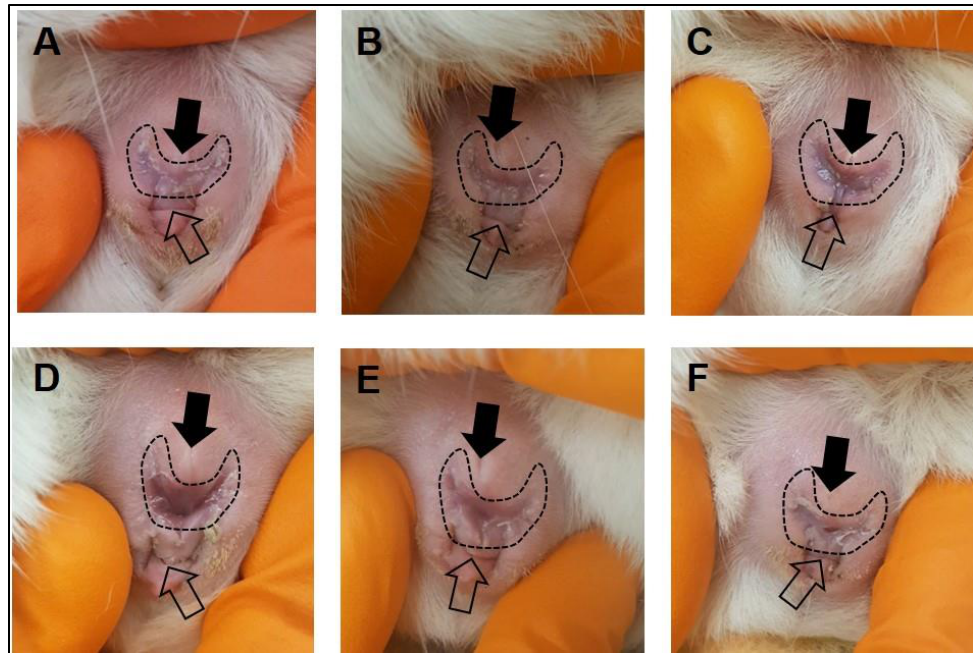
Figure 1. Monitoring of the guinea pig vaginal membrane. During the latent period of the estrus cycle, the guinea pig vaginal membrane (dashed outline) is visibly closed ( A , B ). Four to five days prior to ovulation, changes to the color of the vaginal membrane can be observed indicating potential membrane perforation ( C ). At the time of ovulation, the vaginal membrane perforates and increased vaginal secretions/mucus can be observed ( D ). Following ovulation, the vaginal membrane begins to close ( E , F ). The closed arrow indicates the urethral opening, the open arrow indicates the anus.